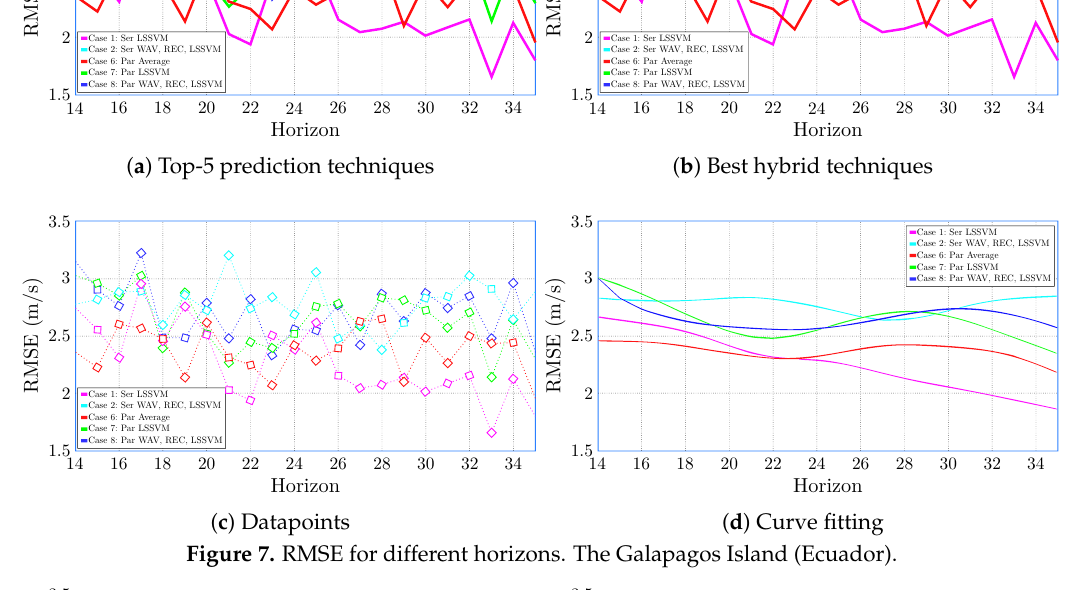
Figure 7. RMSE for different horizons. The Galapagos Island (Ecuador).